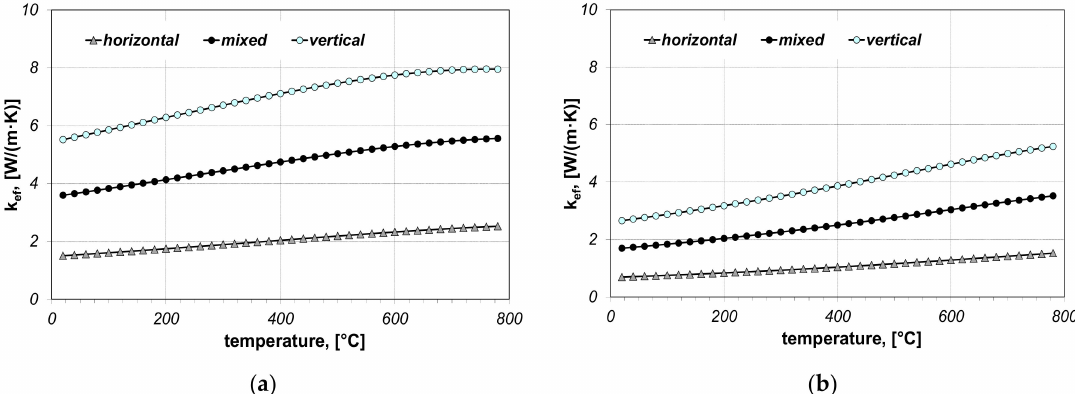
Figure 4. Calculated values of the coefficient k ef for the bundle of 5 × 20 mm bars: ( a ) results obtained for R ct-min , ( b ) results obtained for R ct-max .